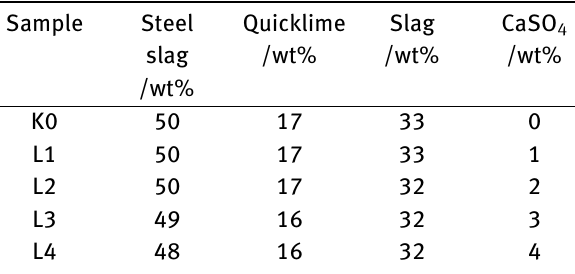
Table 3: Experimental proportions of the reconstructed steel slag with CaSO 4